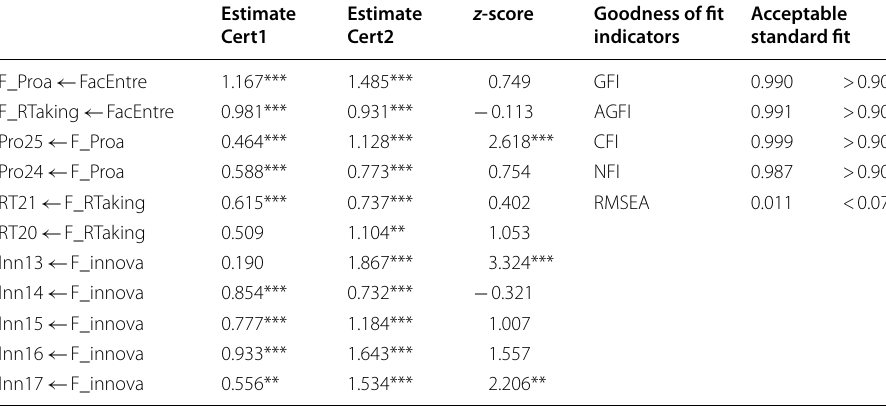
Table 10 SEM results for FEO construct subject to